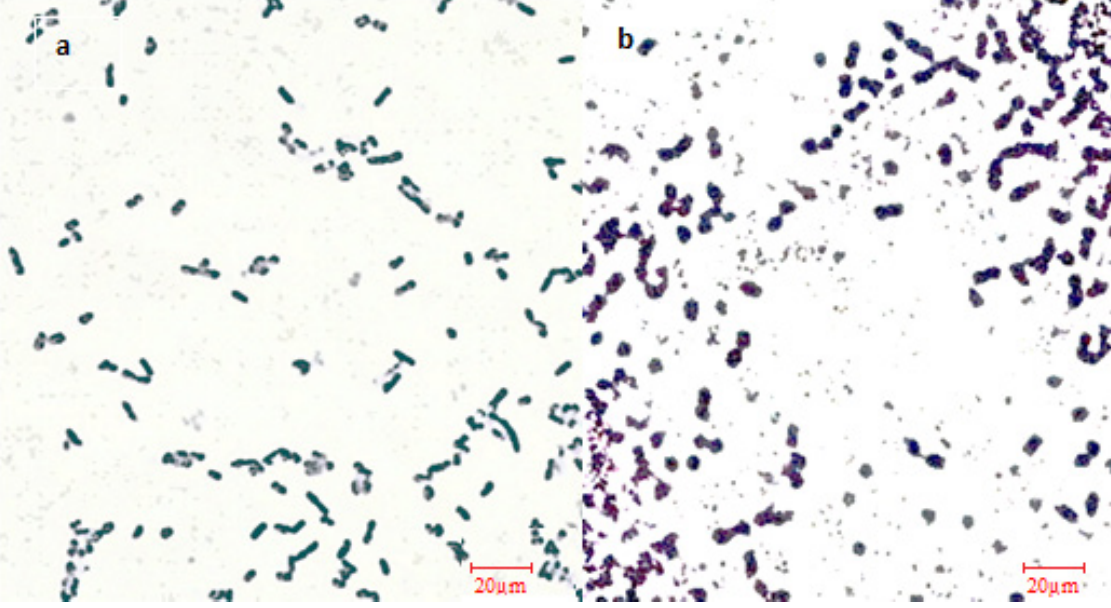
Figure 1: Normal P. orientalis cells (a) Coccoid cells under the influence of sub-inhibited concentration of lemongrass oil (b) (1000x, Axiovert 2000).